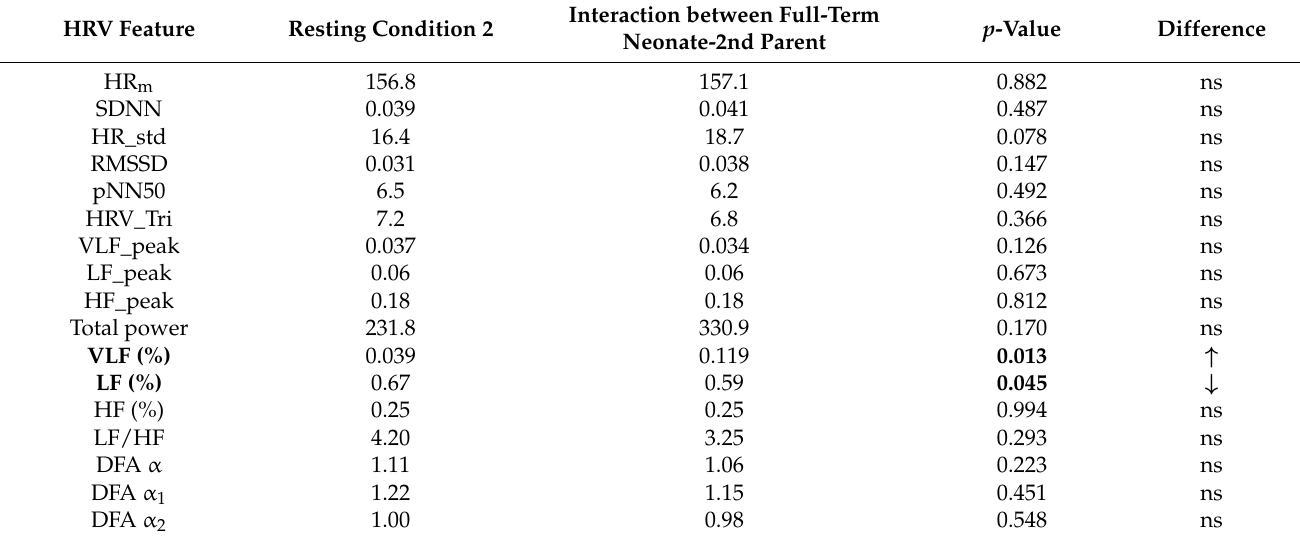
Table 9. Comparison of full-term infants’ HRV parameters between resting condition 2 and interaction with the 2nd